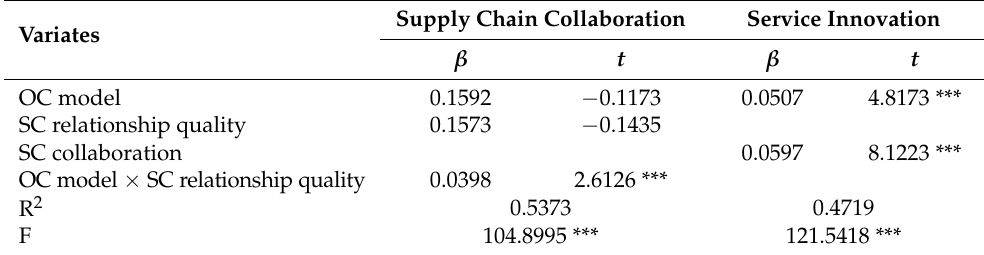
Table 9. Test of mediating effect model with